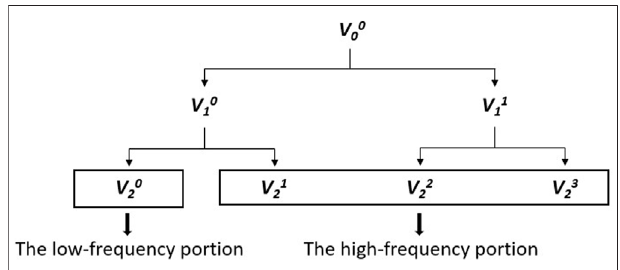
FIGURE 1 | The schematic diagram of a two-layer wavelet packet